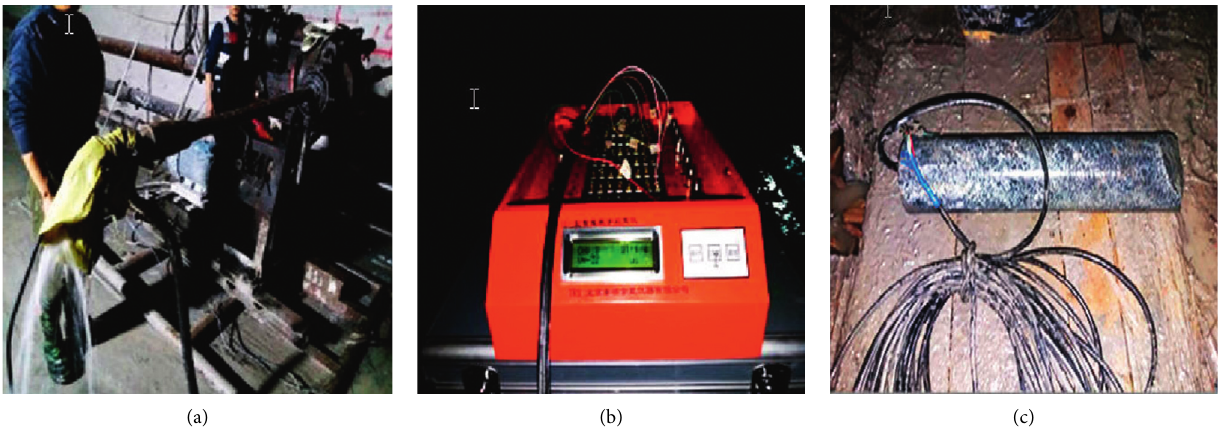
Figure 3: Stress relief process. (a) Core sampling. (b) Data collection. (c) The core with stress gauge.